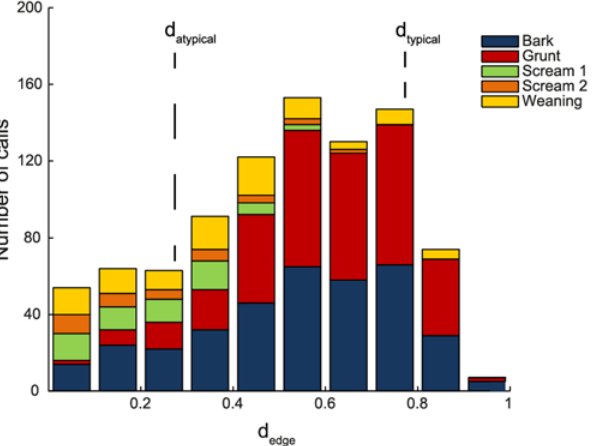
Fig 7. Histogram of typicality coefficients. Sections with different colors indicate calls with different main type. Grunts and barks are more distinctly separated from other call types than screams and weaning